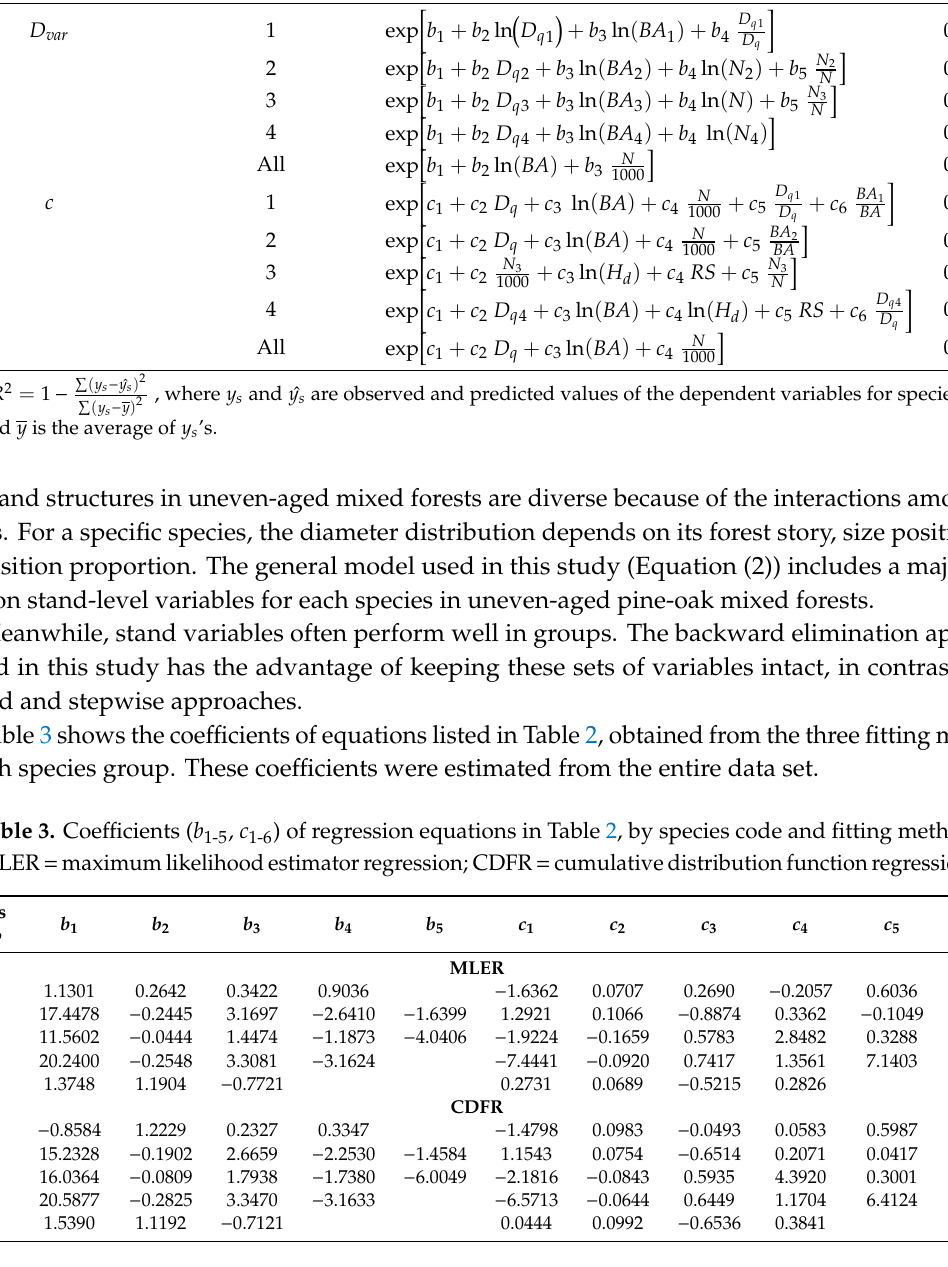
Table 2. Regression equations for diameter variance ( D var ) and Weibull parameter c for each tree species. Dependent Variable